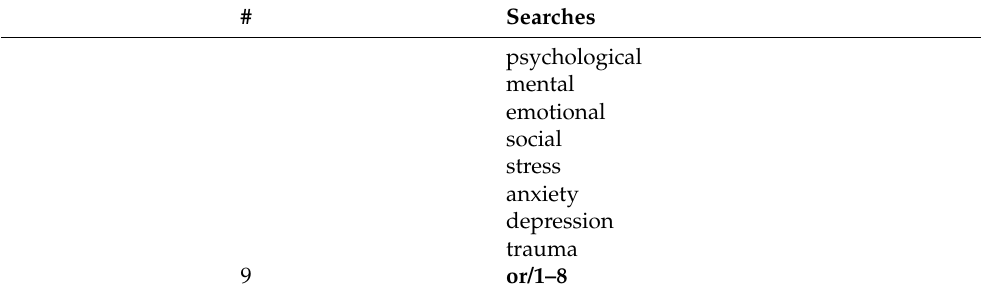
Table A7. Search strategy.